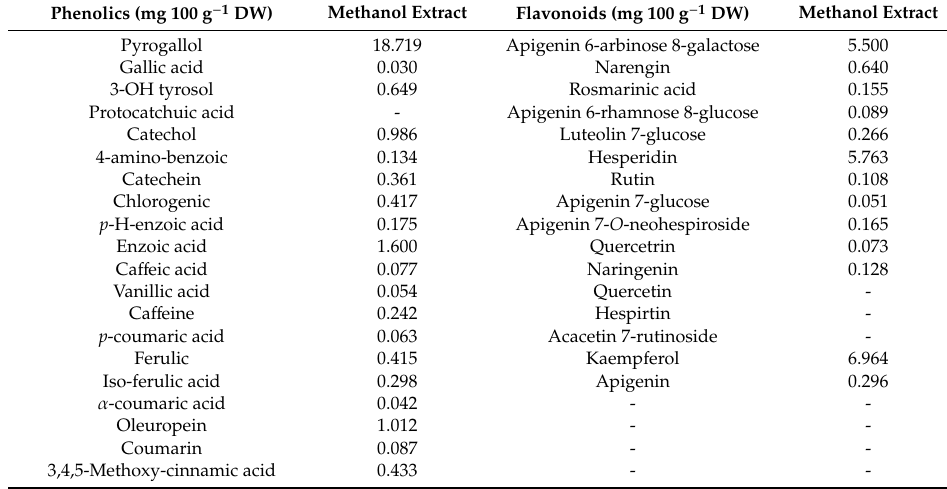
Table 4. The HPLC phenolic profile of common bean plants from well watered treatment (100% ETc) with ascorbic acid dose of 400 mg L − 1 sampled at 46 day after